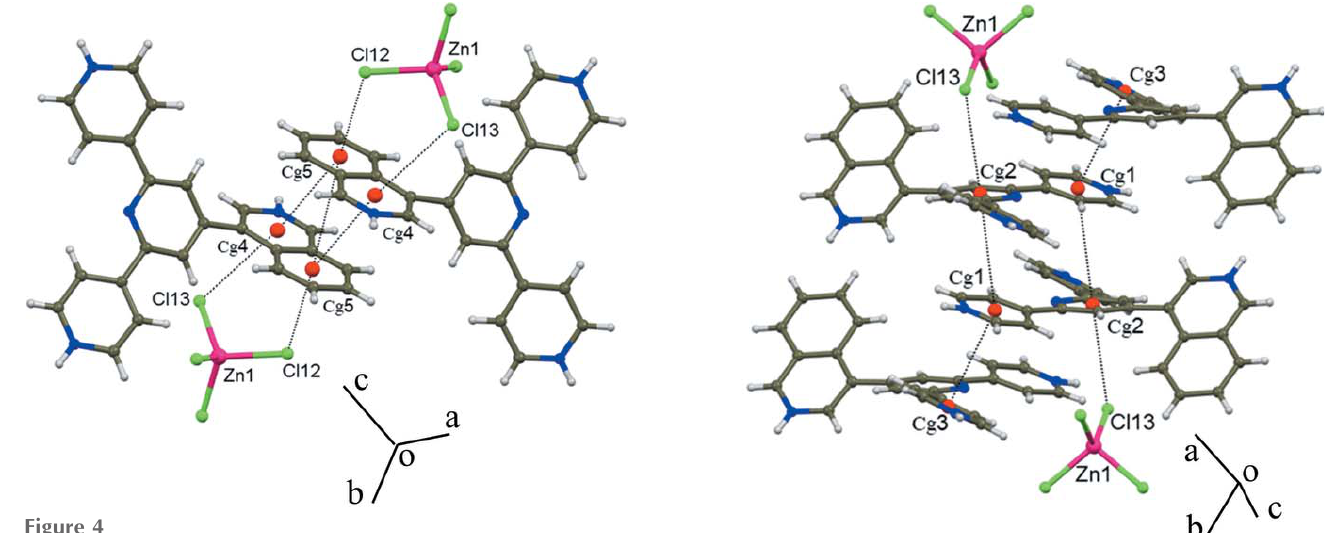
Figure 4 Anion (cid:2)(cid:2)(cid:2) (cid:2) interactions in (I) including the (cid:2) -stacking